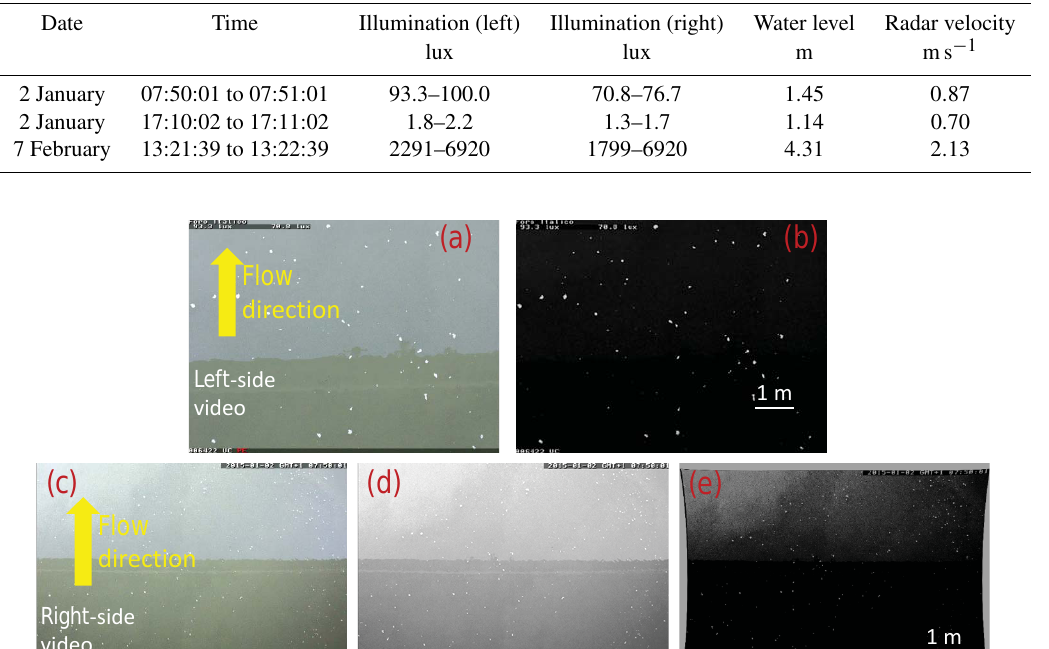
Table 1. Synoptic table for the set of analyzed videos.